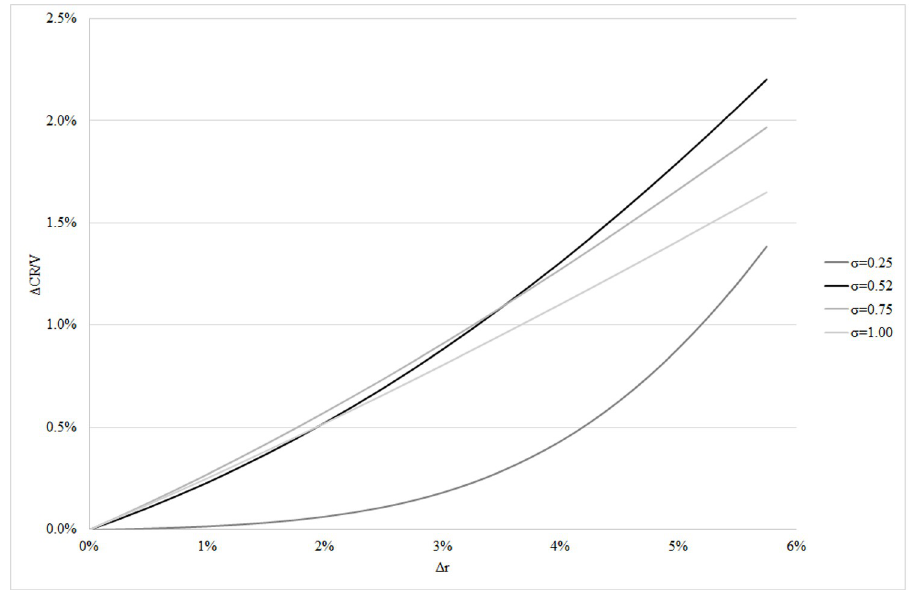
Fig 5. Additional capital need of ARM loans at EU level as a function of Δ r and σ . Figs 4 and 5 demonstrate that the calculation of the additional capital need is highly sensitive to the assumed change in the interest ( Δ r ), parameters related to the average riskiness of the mortgage portfolio ( µ ), and inequality of borrowers in their riskiness ( σ ). If loss given default LGD differs from our assumptions (0.35), the ARM-specific additional capital will change proportionally.